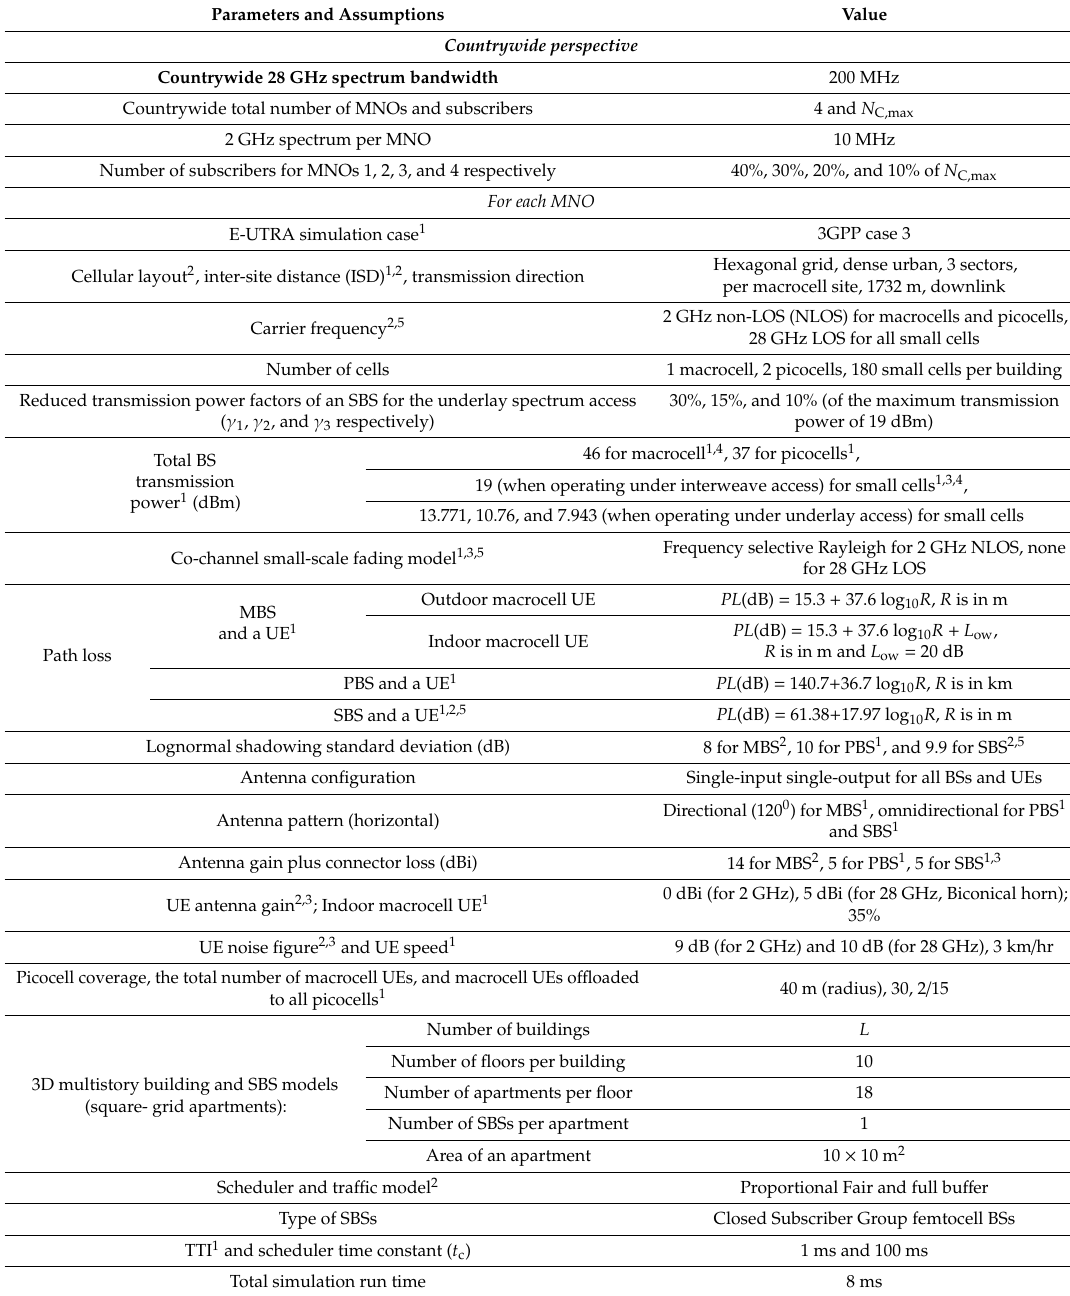
Table 2. Default parameters and